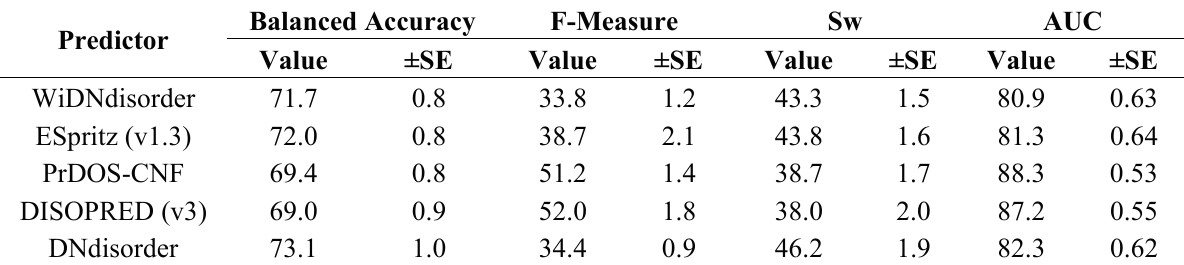
Table 2. Performance of WiDNdisorder on the CASP10